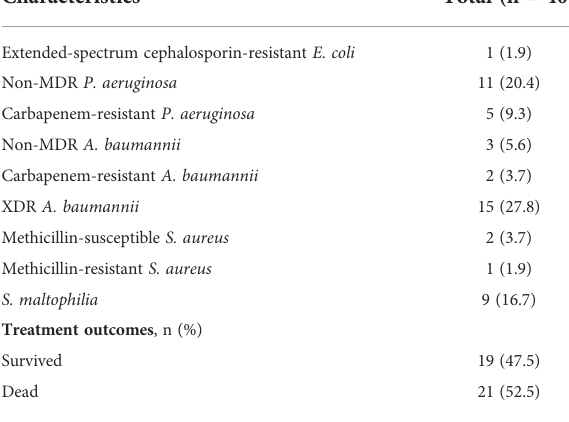
TABLE 2 Baseline characteristics and the conventional microbiological results of study subjects with hospital-acquired pneumonia (HAP) and ventilator-associated pneumonia